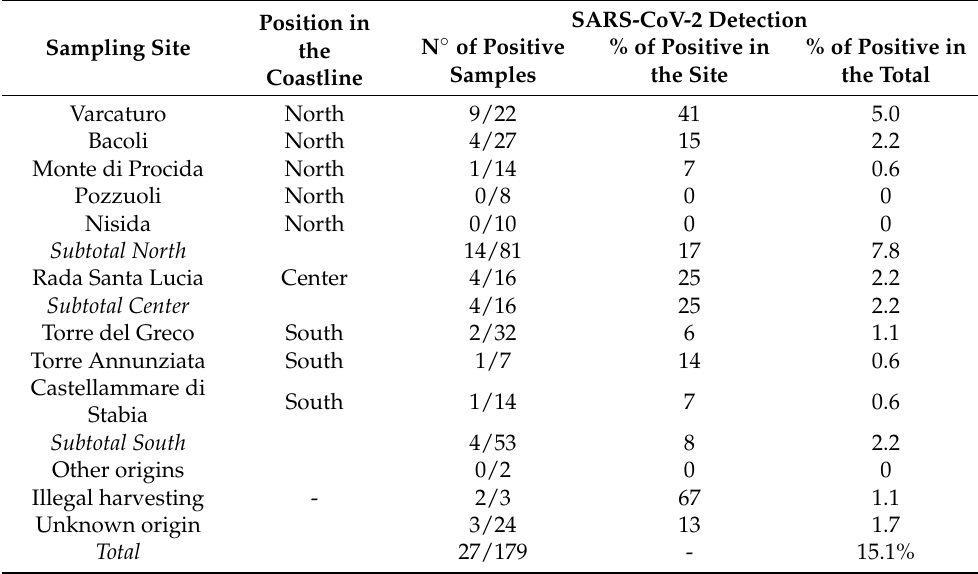
Table 3. Detection of SARS-CoV-2 in bivalve mollusk samples according to sampling site.